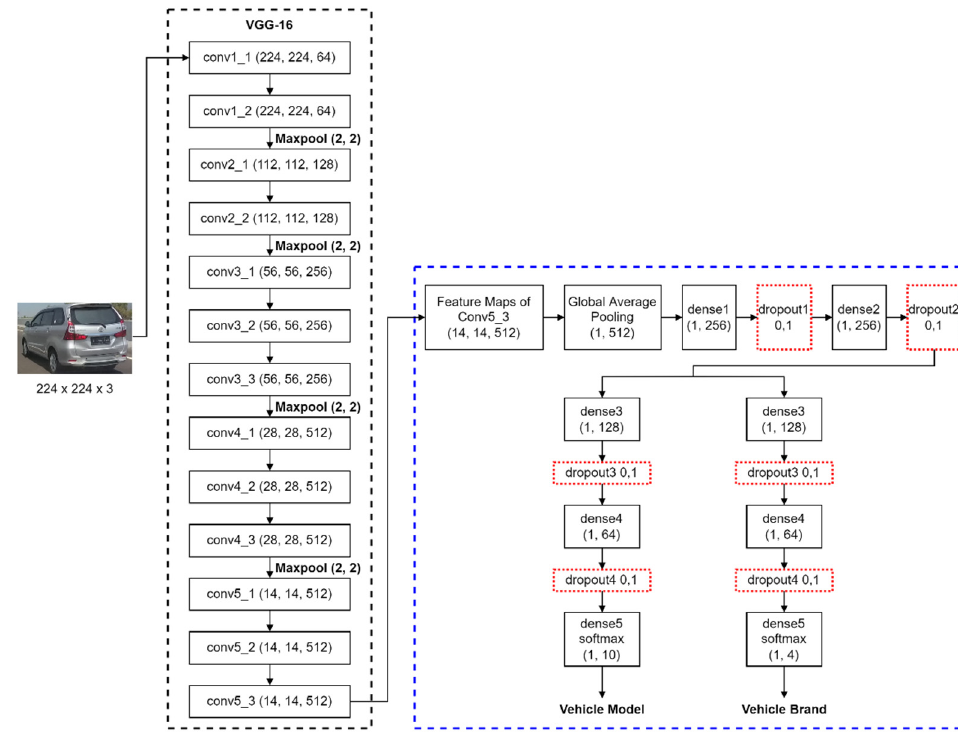
Figure 5. Architecture of proposed multi-task CNN.